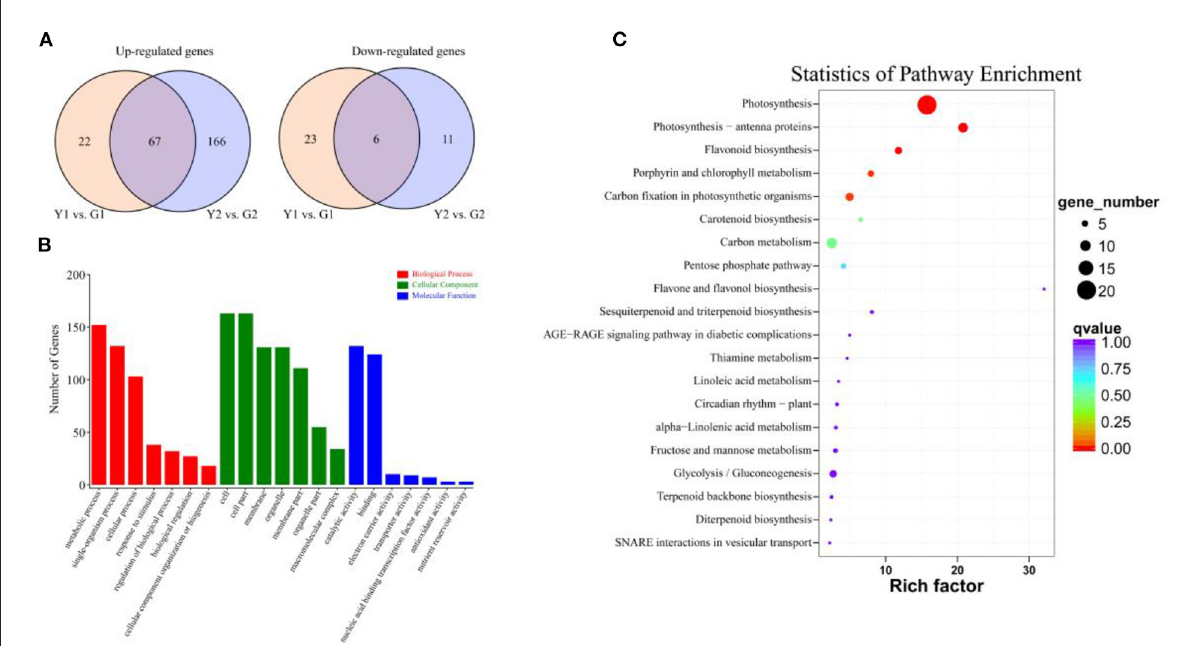
FIGURE3 The number of DEGs identified by comparisons and enrichment analysis. (A) Venn diagrams show the number of up- and down-regulated DEGs in two comparisons. Yellow and blue circle indicates Y1 vs. G1 and Y2 vs. G2 comparisons, respectively. (B) GO enrichment analysis of DEGs, including molecular function (blue bar-graph), cellular component (green bar-graph), and biological process (red bar-graph). (C) KEGG enrichment analysis of DEGs.